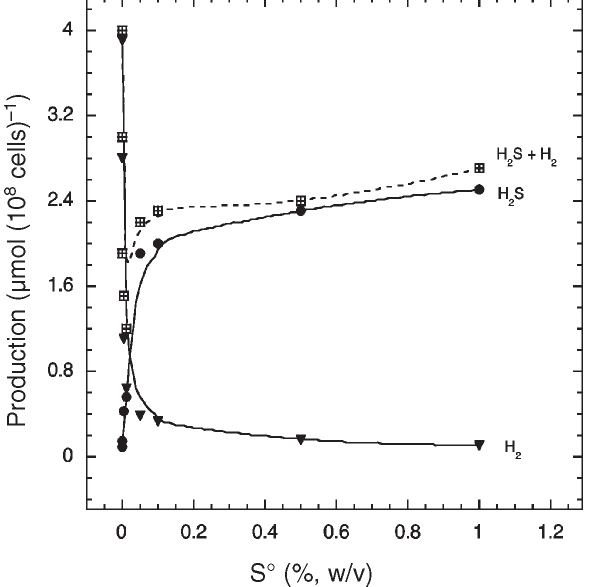
Figure 4. Effects of S ° on the production of H 2 and H 2 S by S. marinus . Production of H 2 and production of H 2 S were calculated from the amountsof H 2 and H 2 S produced during growth and the cell densityat the end of growth. Thus, the units of µmol (10 8 cells) –1 are not compa- rable with specific activities. Cells were grown in 25 ml of modified 0.8× SME medium for 72 h at 85